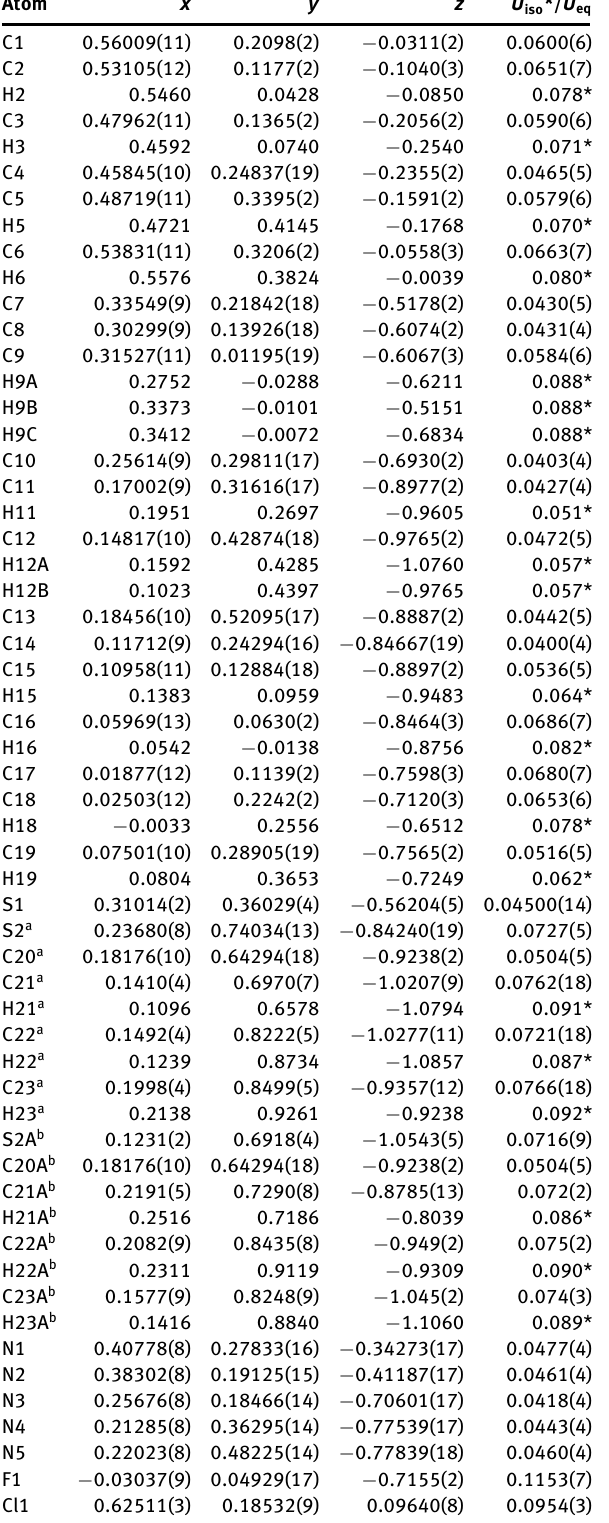
Table 2: Fractional atomic coordinates and isotropic or equivalent isotropic displacement parameters (Å 2